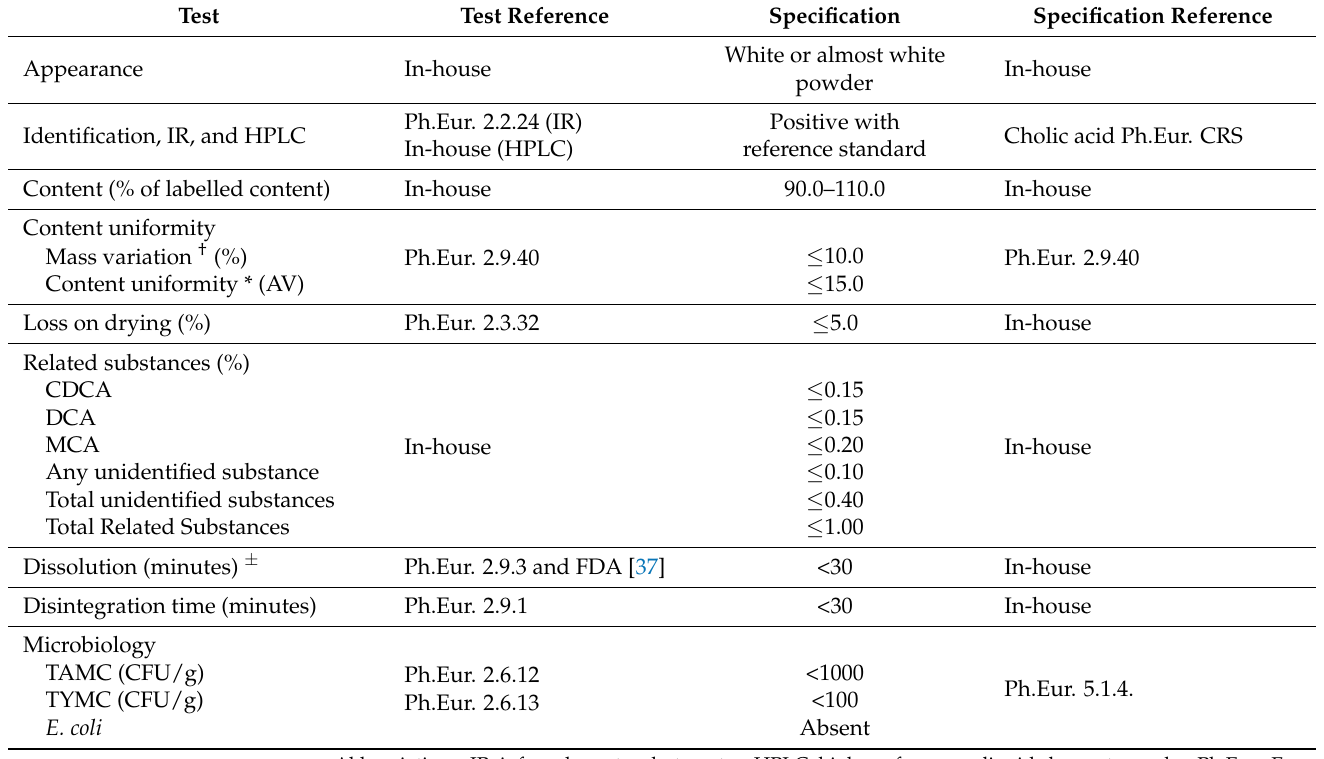
Table 1. Pharmacotechnical test specifications for compounded cholic acid 25 mg and 250 mg capsules.